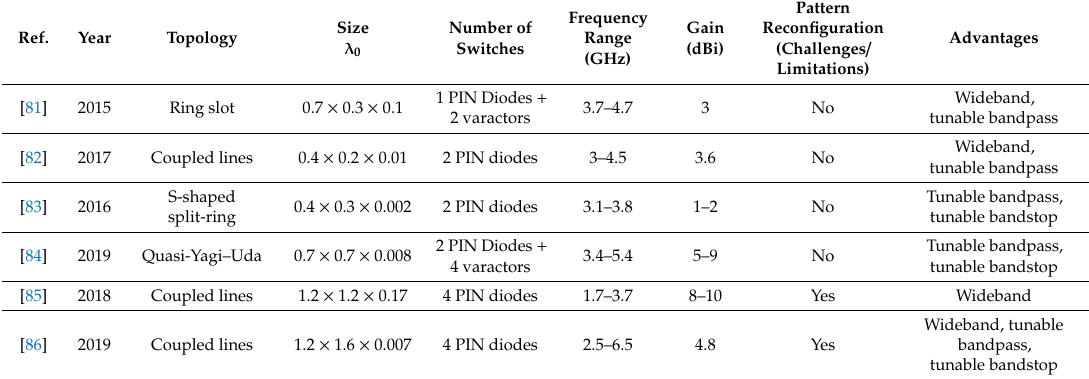
Table 5. Performance comparisons between reconfigurable filter–antenna